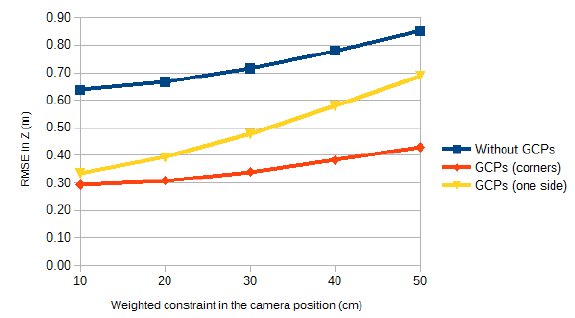
Figure 8. Sensor 1 – RMSE in Z coordinate calculated with four altimetry checkpoints in the BBA.